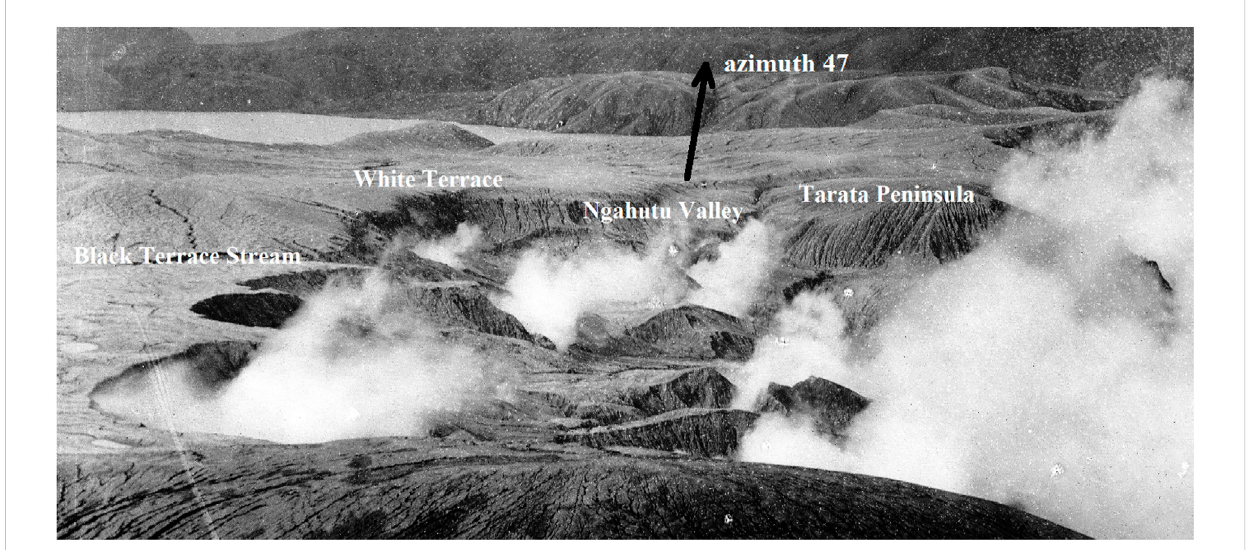
FIGURE 12 Muir ’ s photograph (cropped) of the northwest crater in late July – early August 1886. Black Terrace Stream and surface water are visible beside the near embayments, looking northeast at azimuth 47 ° (Te Papa